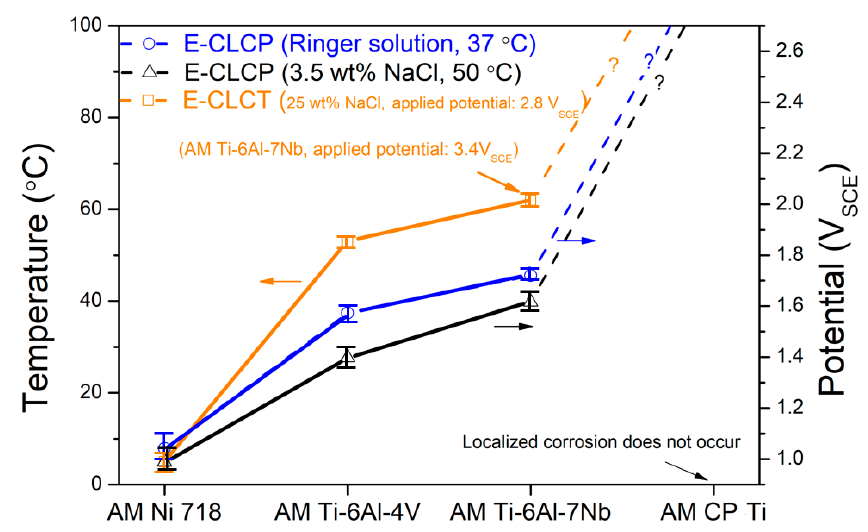
Figure 8. The comparison between the E-CLCT (ISO 22910:2020 [29]) and E-CLCP (ISO/CD 4631: 2021 [30]) values of the AM Ni 718 and AM Ti alloys (note that the E-CLCT test for the AM Ti–6Al–7Nb alloy was performed at the applied potential of 3.4 V SCE ).